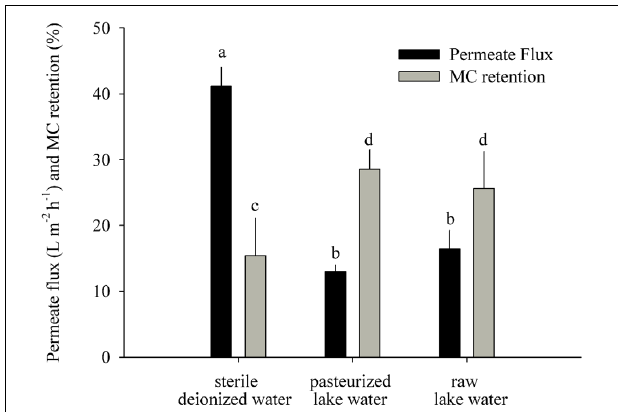
FIGURE 3 | MC retention test: permeate flux and MC retention measured 22 h after addition of MC-containing biomass to the GDM system (means ± one standard deviation). Letters denote treatments that are significantly different for the permeate flux and for the MC retention, respectively (ANOVA followed by Tukey’s HSD tests, p < 0.001–0.05).